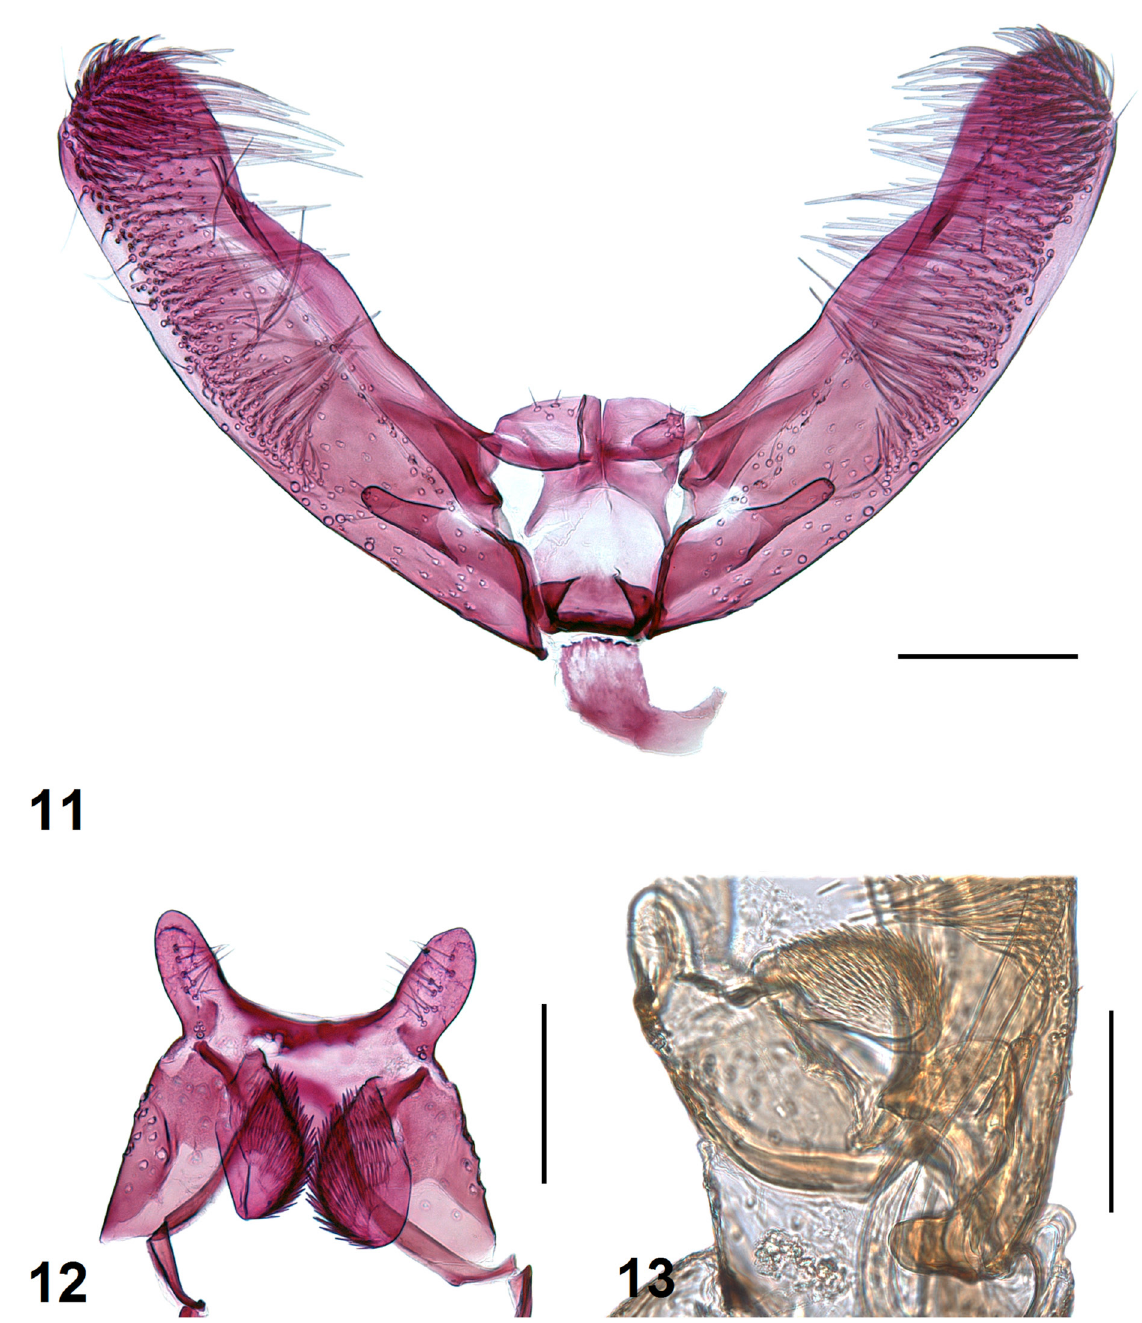
Figs 11–13. Elachista buszkoi Sruoga & Kaila sp. nov., paratype, ♂ (MZH VS2/29.03.19). 11 . Valvae, juxta and digitate processes. 12 . Tegumen, uncus and gnathos. 13 . Juxta, tegumen and gnathos, lateral view (in glycerol before permanent mounting in Euparal). Scale bars = 0.1